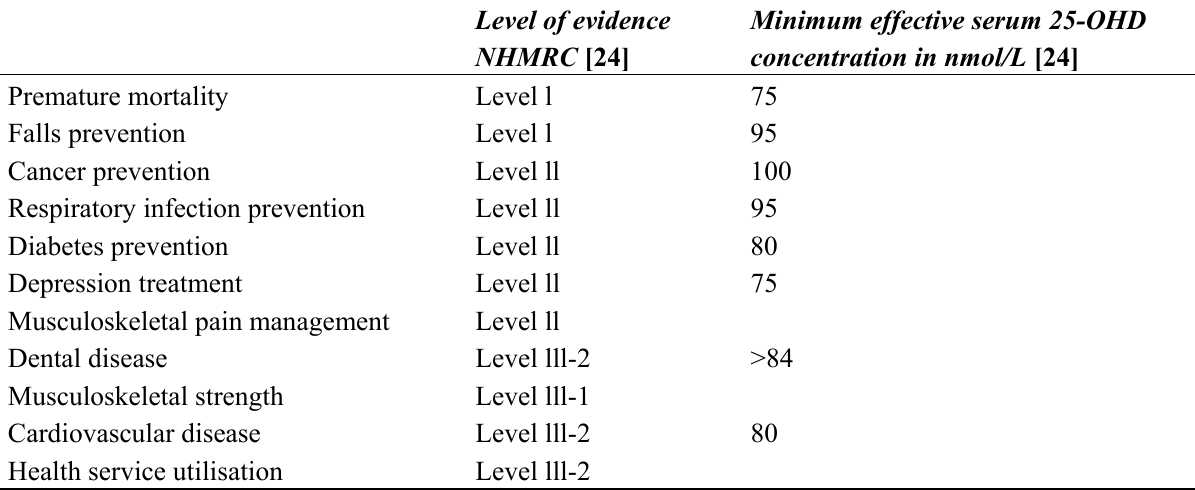
Table 2. Proposed vitamin D concentrations in the management of non-skeletal